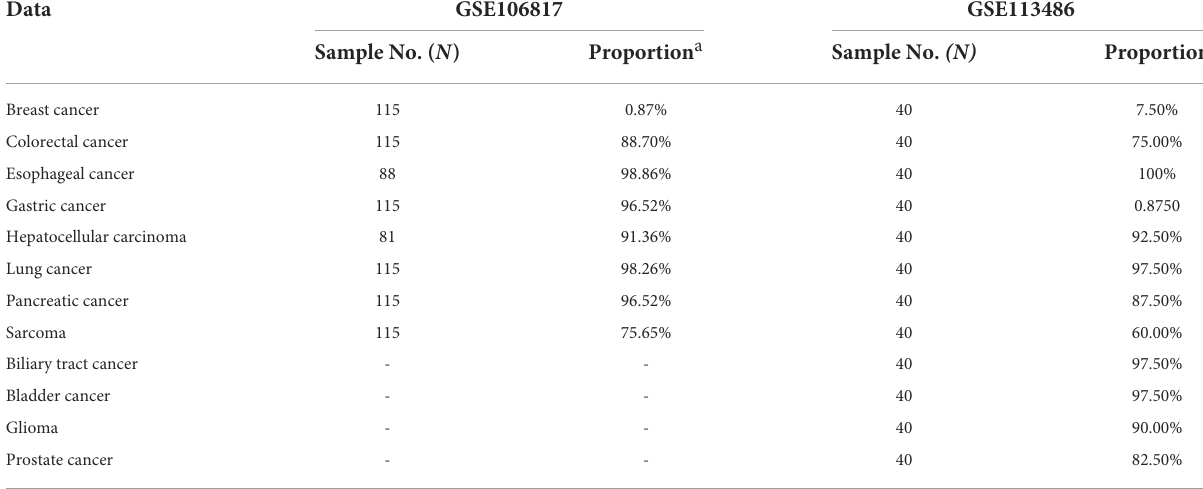
TABLE 4 Diagnosis of multiple cancer types by the 13-miRPairs